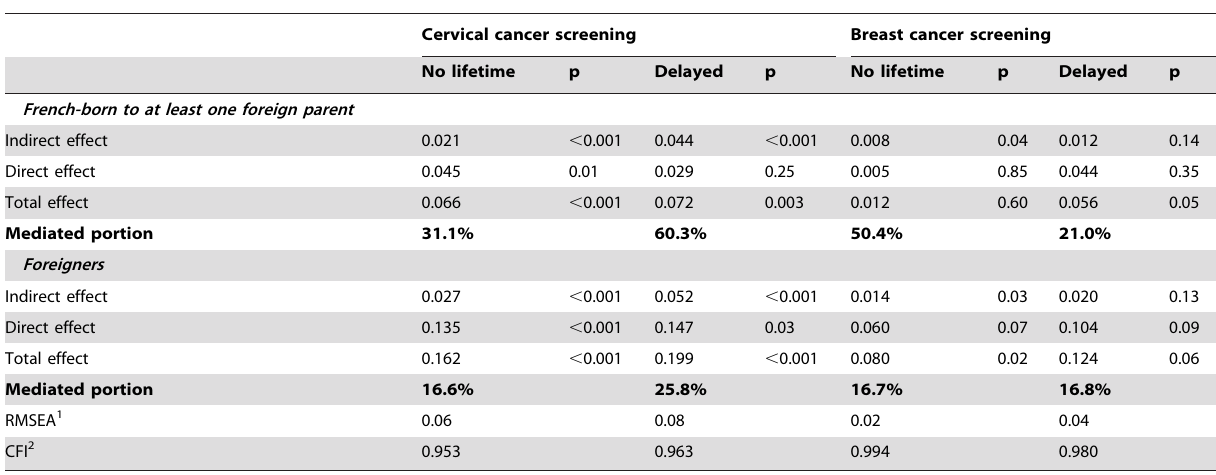
Table 2. Results of the structural equation